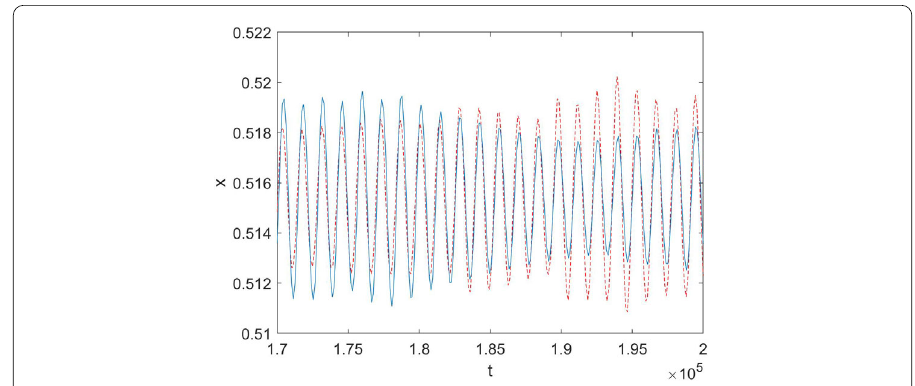
Figure 12 Computer simulations of the system of Eqs. (4)–(6) with c 1 = 0.85 day –1 , c 2 = 0.95 day –1 , c 3 = 0.239 day –1 , c 4 = 0.84 day –1 , c 5 = 0.5 day –1 , k 1 = 67.5, k 2 = 0.02, k 3 = 0.9, h 1 = 0.024, h 2 = 0.063, e 1 = 0.0001 day –1 , e 2 = 0.95 day –1 , e 3 = 0.56 day –1 , γ 1 = 0.02 day –1 , γ 2 = 0.085 day –1 , (cid:8) = 0.004 and δ =